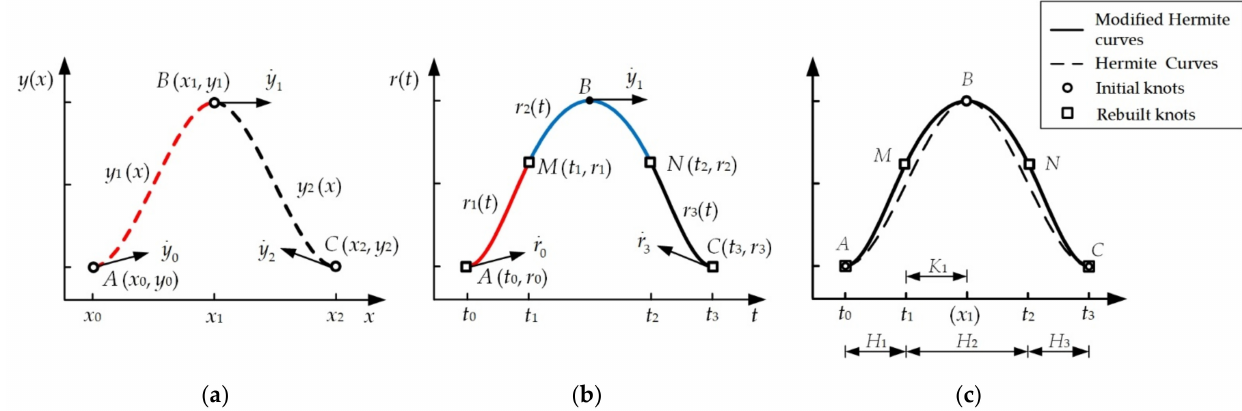
Figure 7. Piecewise cubic Hermite interpolation curves with three initial knots: ( a ) Interpolation with initial knots; ( b ) Interpolation with rebuilt knots; ( c ) Comparison between two kinds of